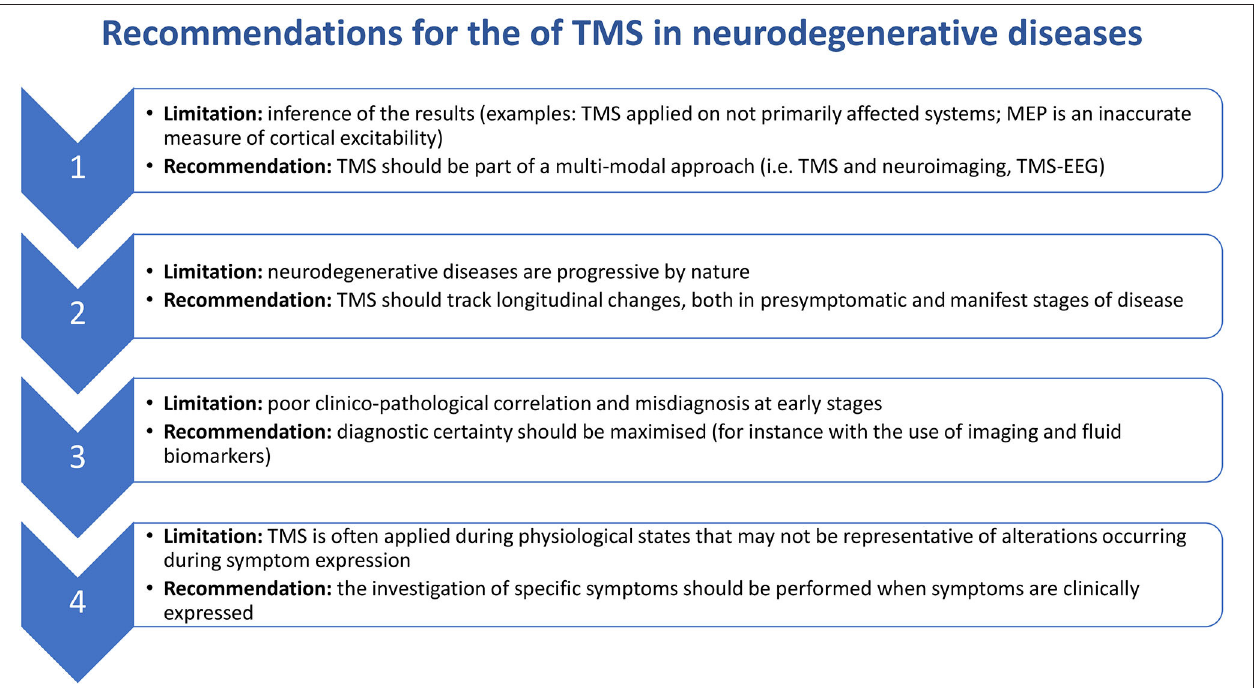
FIGURE 1 | Recommendations for the use of TMS in neurodegenerative